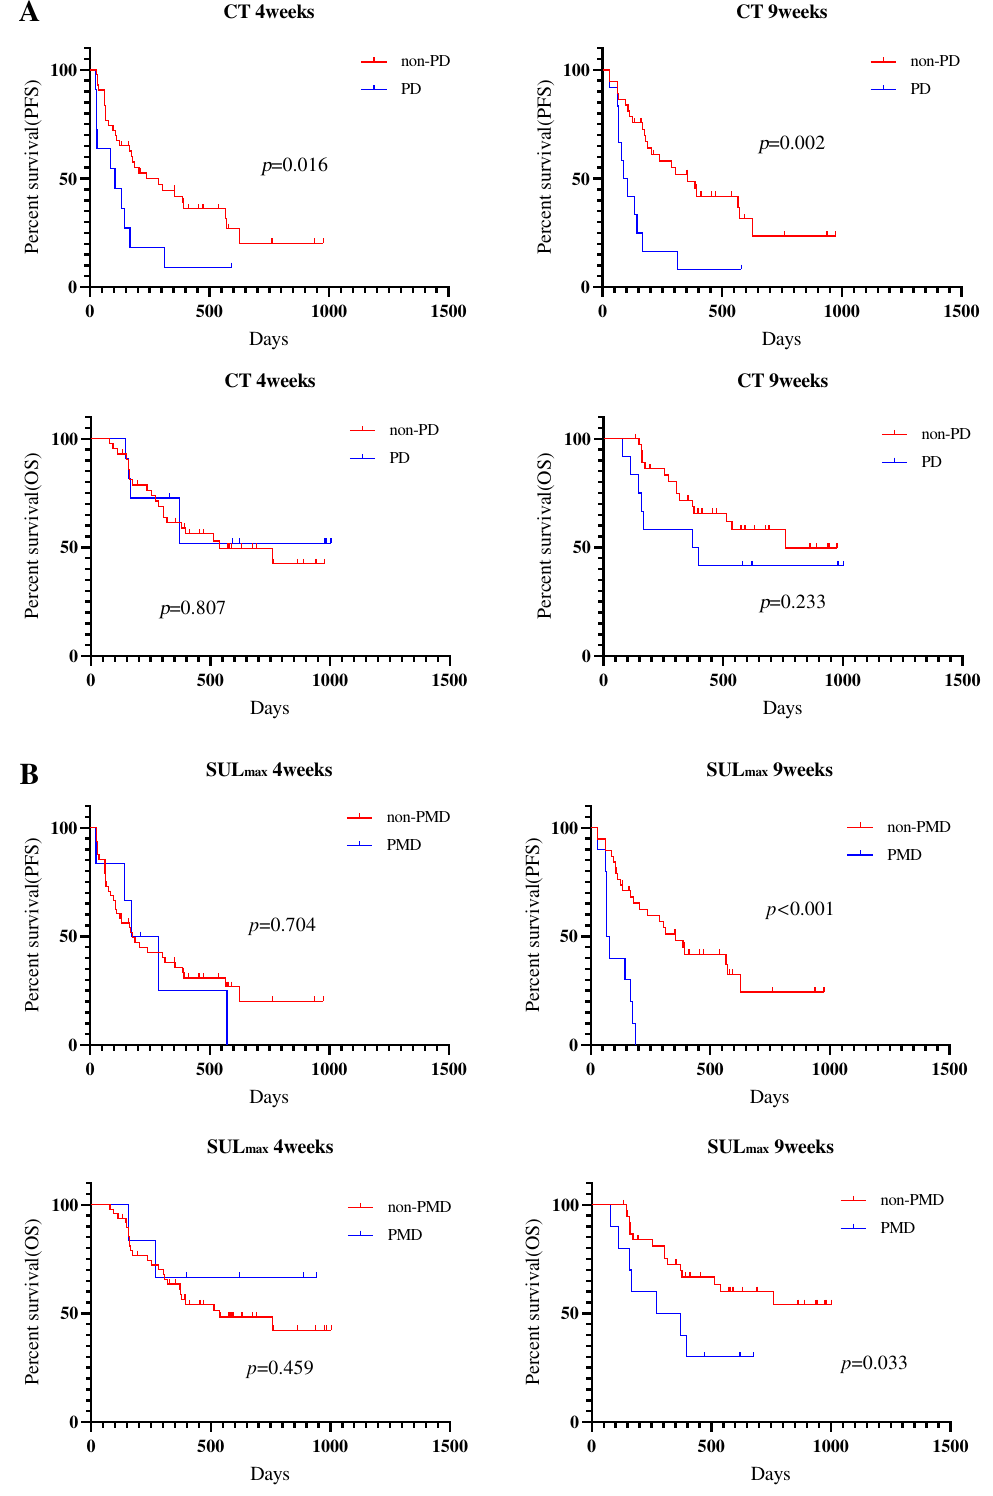
Figure 2. Kaplan–Meier curve of PFS and OS according to CT and 18 F-FDG uptake at 4 and 9 weeks after PD-1 blockade initiation in all patients (n = 54). A significant difference in PFS, but not in OS, was noted between PD and non-PD defined according to CT at 4 and 9 weeks ( A ). A significant difference in PFS and OS was identified between PMD and non-PMD defined according to the 18 F-FDG uptake by SUL max ( B ) and SUL peak ( C ) at 9 weeks, but not at 4 weeks. A significant difference in PFS and OS was identified between PMD and non-PMD defined according to 18 F-FDG uptake by MTV ( D ) and TLG ( E ) at 4 and 9